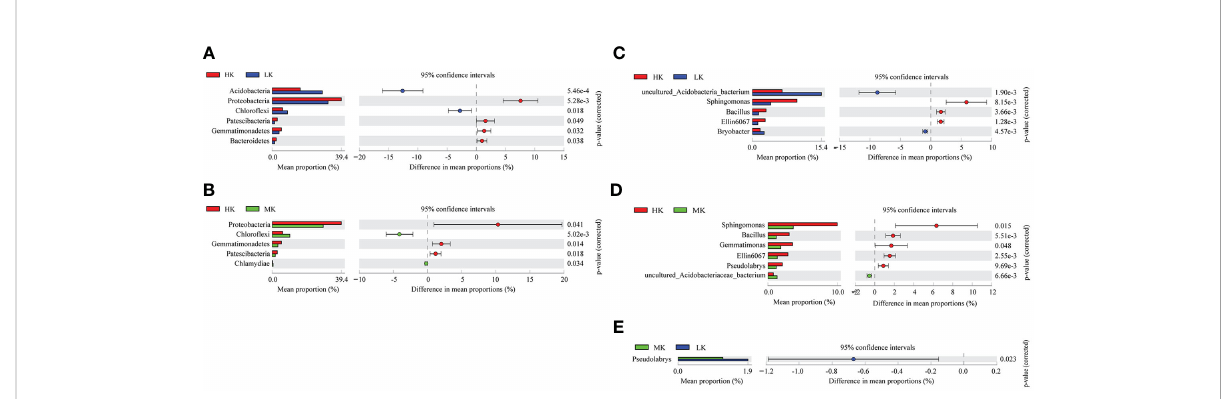
FIGURE 4 Comparative analysis of the top 20 species phyla and genera with signi fi cant differences between different treatments. (A) Differences at phylum level between LK and HK. (B) Differences at phylum level between LK and MK. (C) Differences at genus level between LK and HK. (D) Differences at genus level between MK and HK. (E) Differences at genus level between MK and LK. Only signi fi cant differences are shown ( P < 0.05); LK, Low amount of K